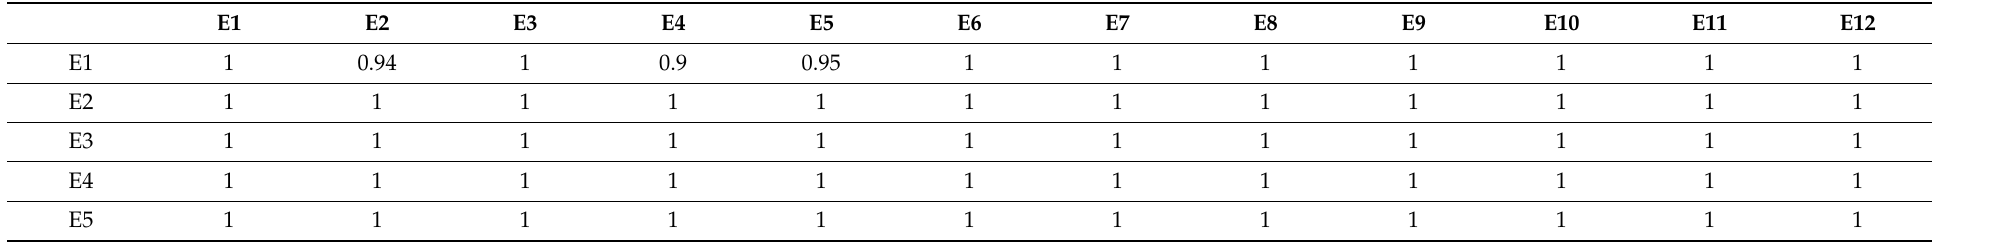
Table A7. Effect–effect matrix to